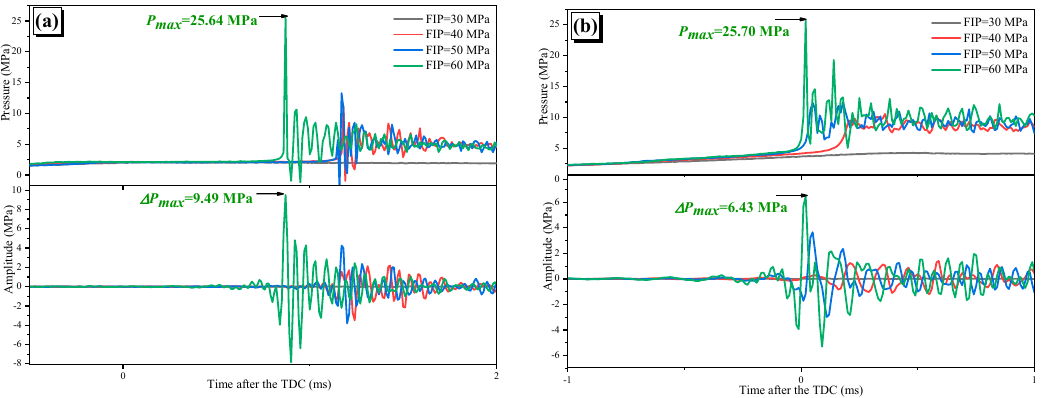
Figure 7. In-cylinder pressure and pressure oscillations for: ( a ) T c = 930.8 K, P c = 2.14 MPa, ∆ t = 2.0 ms; ( b ) T c = 921.4 K, P c = 4.13 MPa, ∆ t = 2.0 ms.